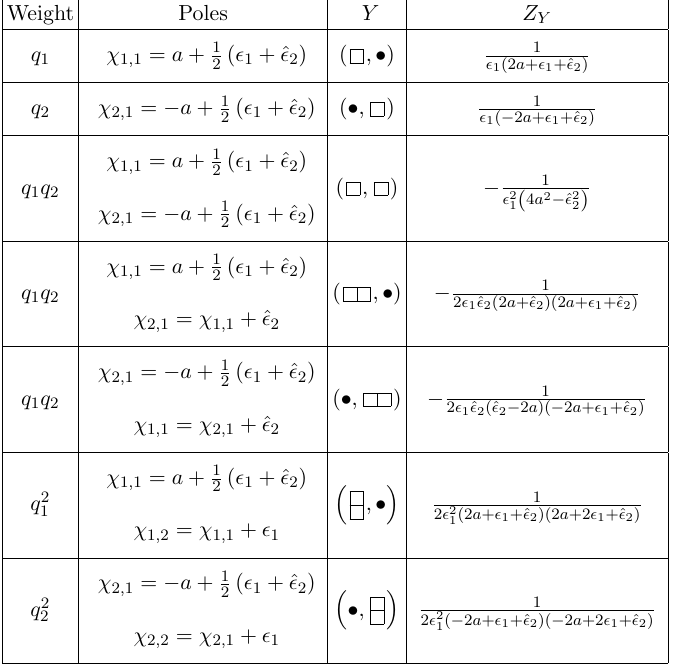
Table 1 . We list the weight factors, the locations of the poles, the corresponding Young diagrams, and the contribution to the partition function in all cases up to two boxes for the SU(2) theory. Here we have set a 1 = (cid:0) a 2 = a